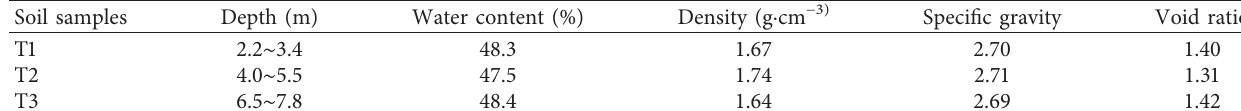
Table 3: Physical parameters of soil samples.